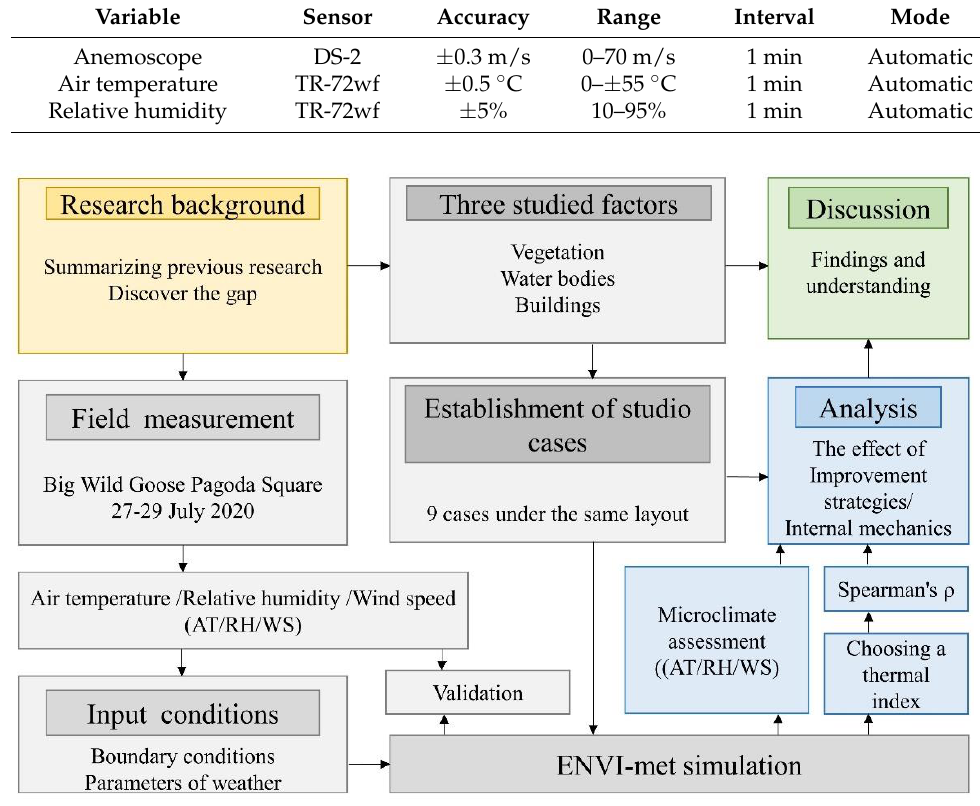
Figure 1. Study area location and Sites 1 – 4.